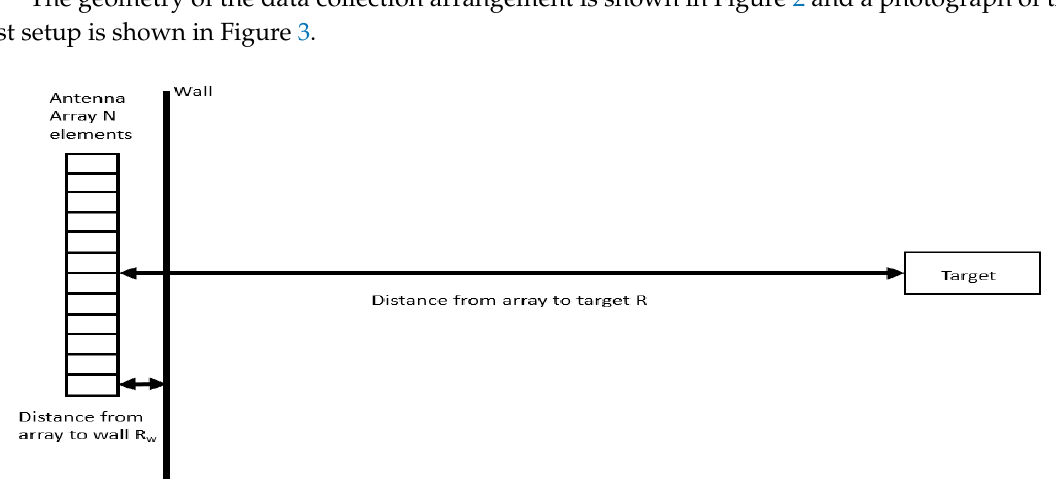
Figure 3. Photograph showing the cart with the horn antennas mounted and the wall behind which the targets were located.